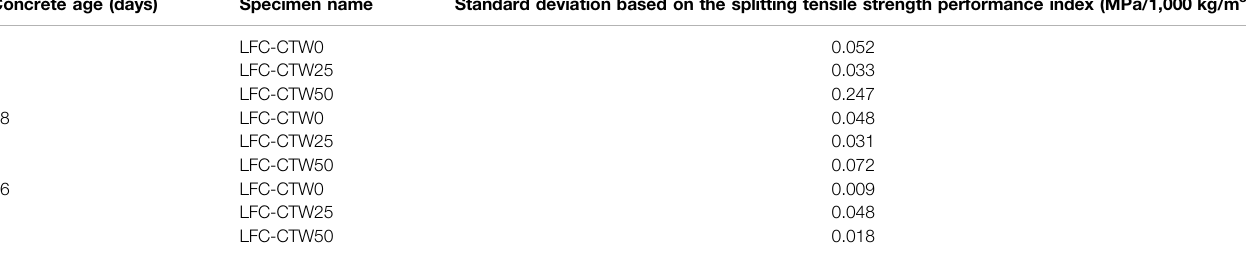
TABLE 7 | Standard deviation of the splitting tensile strength performance index for each mixture.